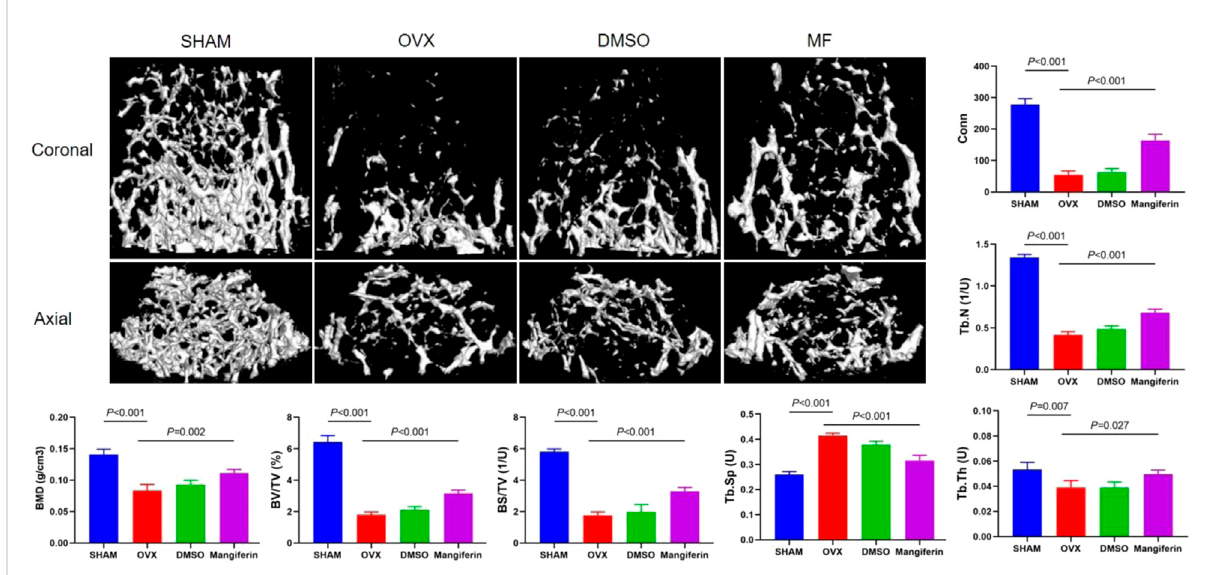
FIGURE 7 Micro-CT of the femur in the SHAM, OVX, DMSO, and mangiferin group. When compared with the SHAM group, the value of BMD, BV/TV, BS/ TV, Tb. Th, Tb. N, and Conn signi fi cantly decreased in the OVX and DMSO groups ( p < 0.01, respectively). When compared with the OVX group, the level of BMD, BV/TV, BS/TV, Tb. Th, Tb. N, and Conn signi fi cantly increased in the mangiferin group ( p < 0.05, respectively). While the value of Tb. Sp presented the opposite trend. Note : MF,